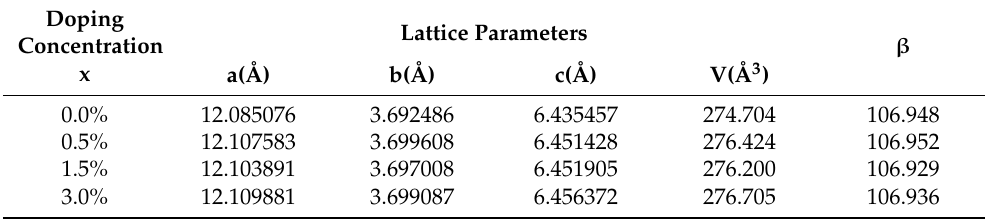
Table 1. The calculated lattice constants (a, b, c, β ) and unit cell volumes (V) of the Zn-VO 2 (B) samples.